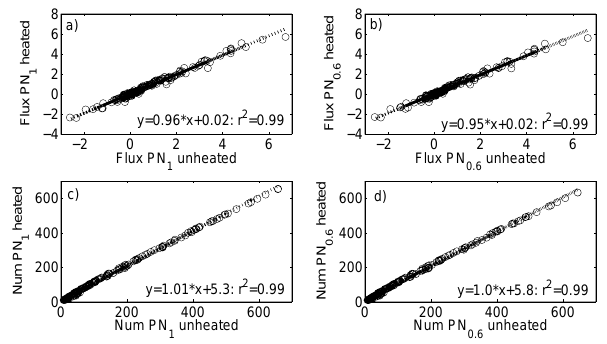
Fig. 3. Correlation between the two OPCs for ambient temperatures (a) particle number flux PN 1 (b) particle number flux PN 0 . 6 (c) par- ticle number concentration PN 1 (d) particle number concentration PN 0 . 6